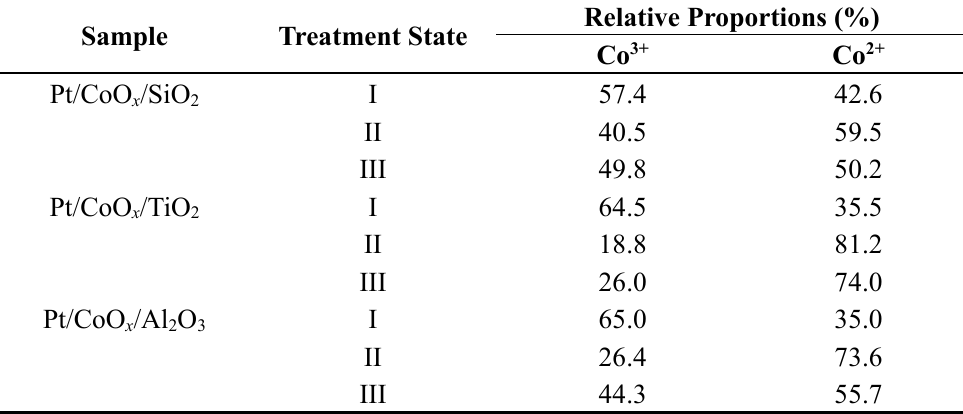
Figure 15. Co-2p XPS spectra of the calcined, reduced, and spent Pt/CoO x /SiO 2 . Table 5. The binding energies and relative proportions (peak areas) of different Pt species as observed from the Co-2p XPS spectra of the calcined (I), H 2 pretreated (II) and spent (III) Pt/CoO x /SiO 2 , Pt/CoO x /TiO 2 , Pt/CoO x /Al 2 O 3